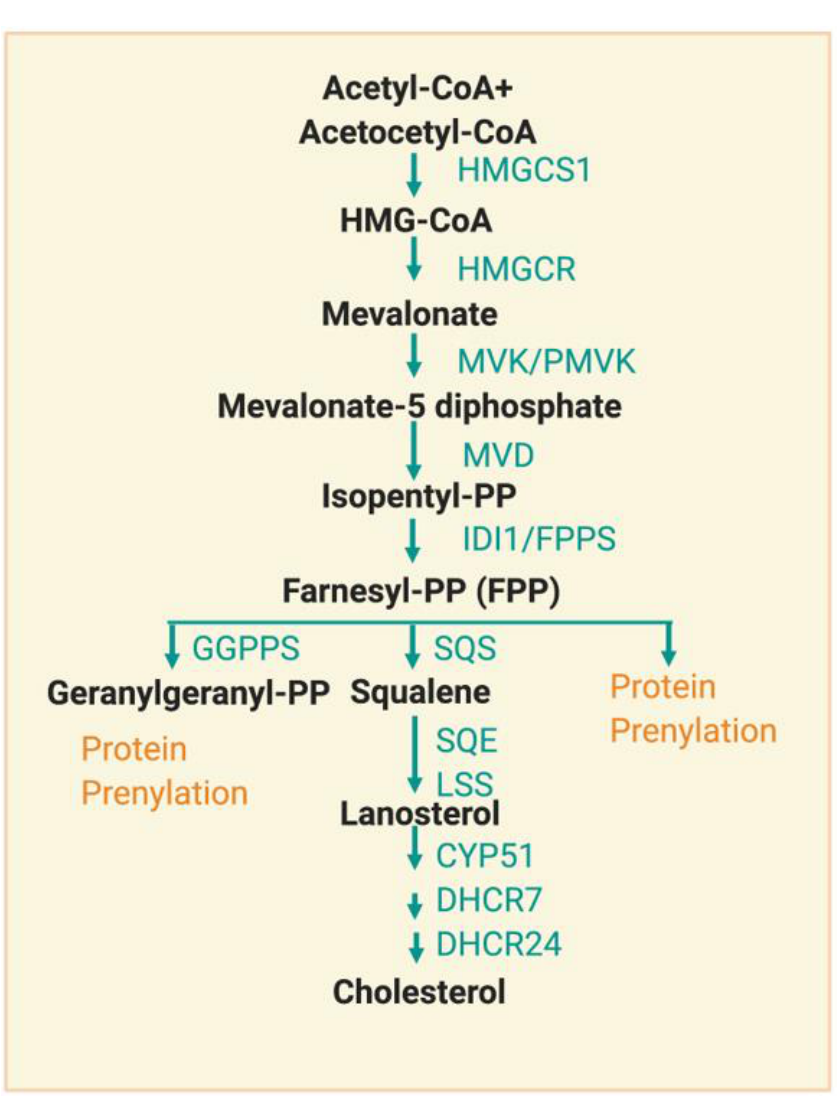
Figure 2. Overview of the cholesterol synthesis pathway. The cholesterol synthesis pathway uses acetyl-CoA and generates isoprenoid intermediates and cholesterol. Sequential molecules and key enzymes are described in a schematic diagram. HMGCS1, 3-hydroxy-3-methylglutaryl-CoA synthase 1; HMGCR, 3-hydroxy-3-methylglutaryl-CoA reductase; MVK, mevalonate Kinase; PMVK, phosphomevalonate kinase; MVD, mevalonate diphosphate decarboxylase; IDI1, isopentenyl-diphosphate delta isomerase 1; FPPS, farnesyl pyrophosphate synthase; GGPPS, geranylgeranyl diphosphate synthase; SQS, squalene synthase; SQE, squalene epoxidase; LSS, lanosterol synthase; CYP51, lanosterol 14alpha-demethylase; DHCR7, 7-dehydrocholesterol reductase; DHCR24, 24-dehydrocholesterol reductase. Green letters indicate enzymes and orange letters indicate protein modification.